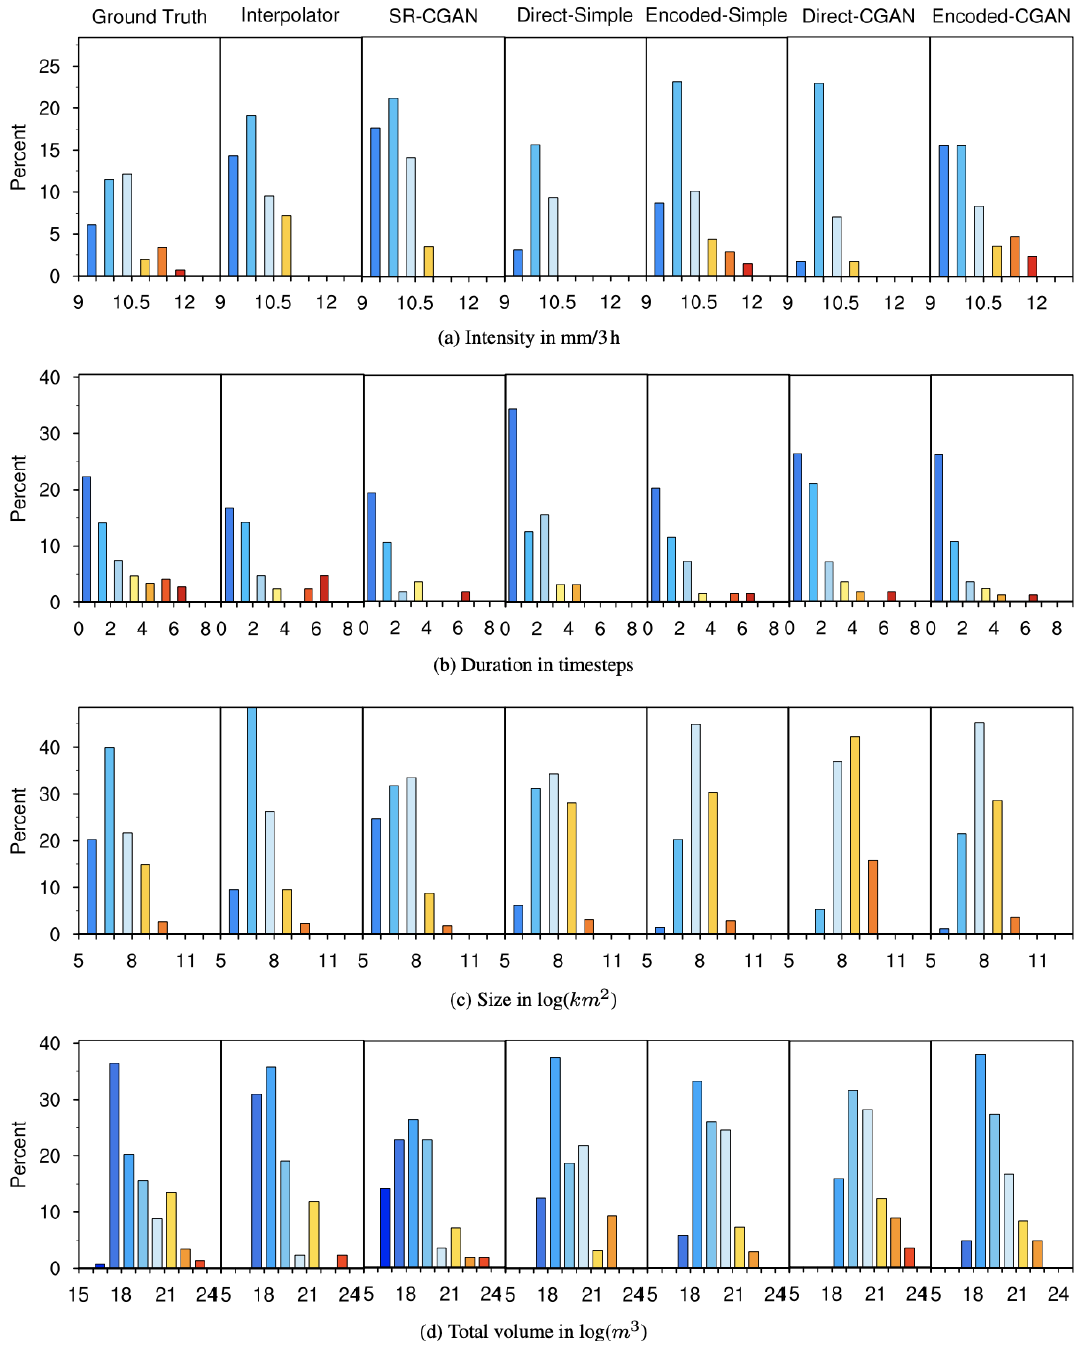
Figure 11. Relative frequency (as %) of certain event-based precipitation characteristics: (a) lifetime mean intensity, mm/3h; (b) duration in (3h) time steps; (c) lifetime mean size, km 2 ( x axis is in log); and (d) total volume, m 3 ( x axis is in log), during event